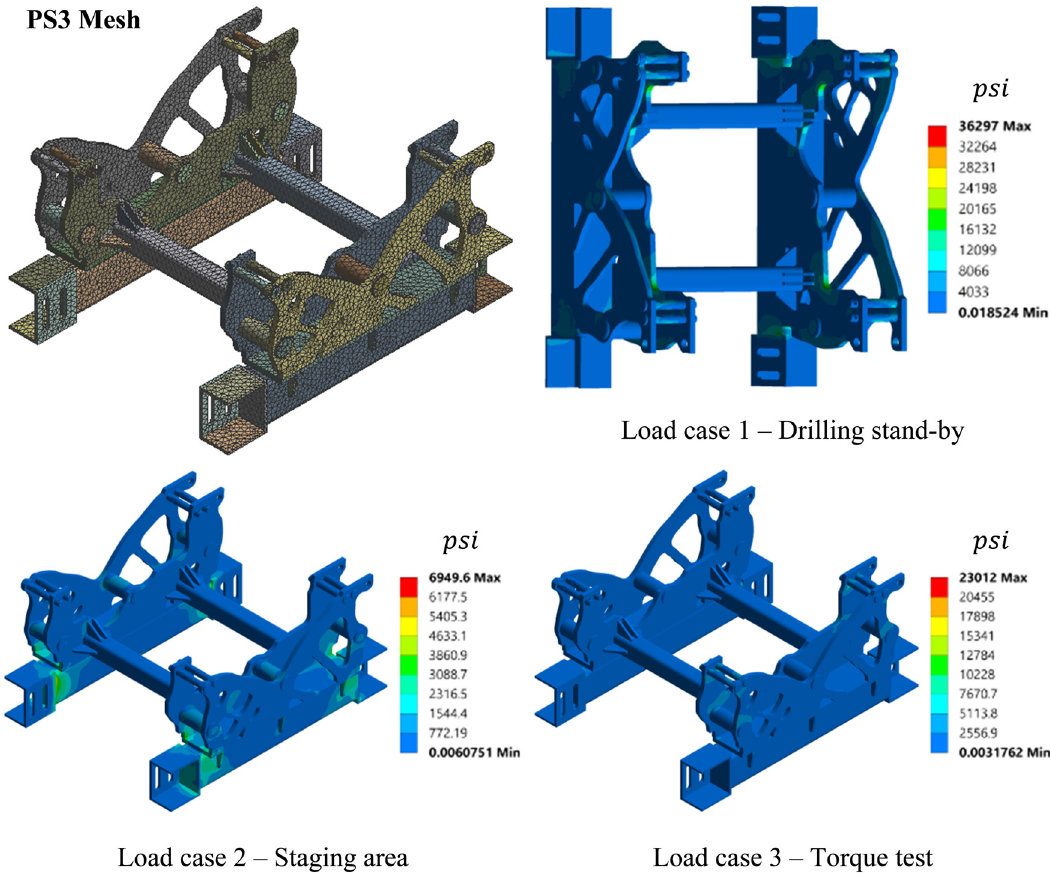
Figure 18: Structural response of topology - optimized result from PS3 against three load cases.